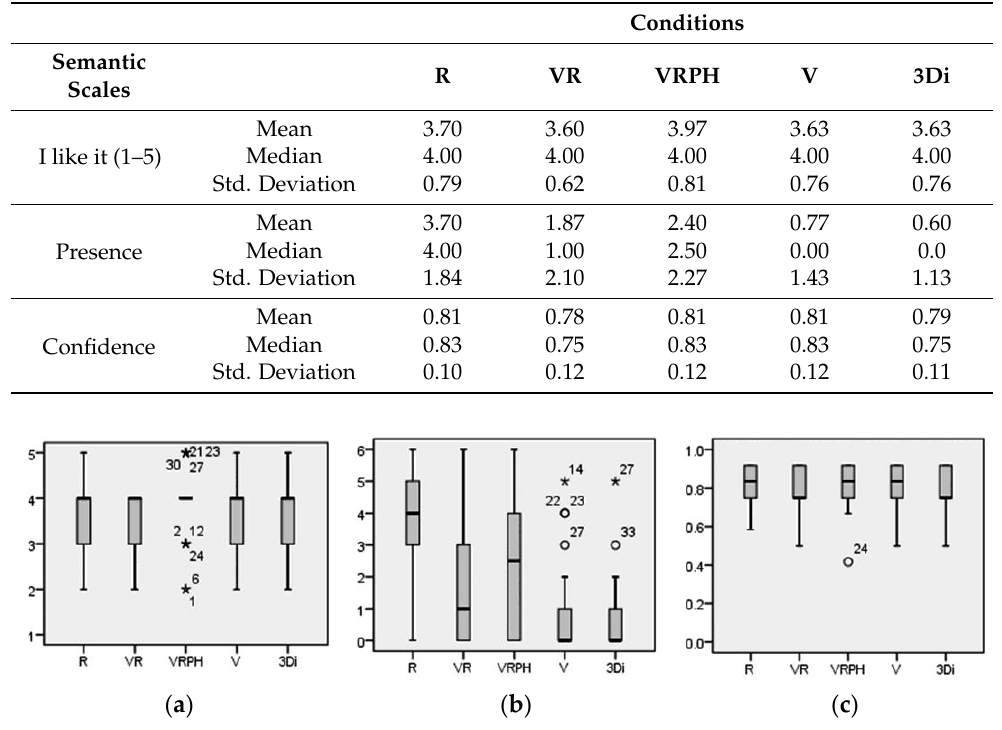
Table 3. Descriptive statistics for the “I like it” question, presence, and confidence.